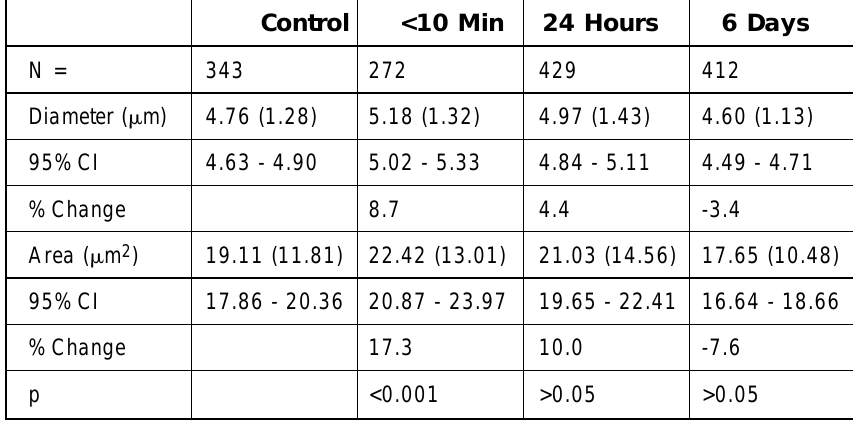
Table 1:The capillary diameters ( (cid:2) m ) and cross sectional areas ( (cid:2) m 2 ) of the control and DTF treated groups are expressed as means, one standard deviation and the 95% confidence interval (95% CI). The percentage change from the control group is given (% Change). The statistical significance of the change between the control group and the treated groups is shown (p).